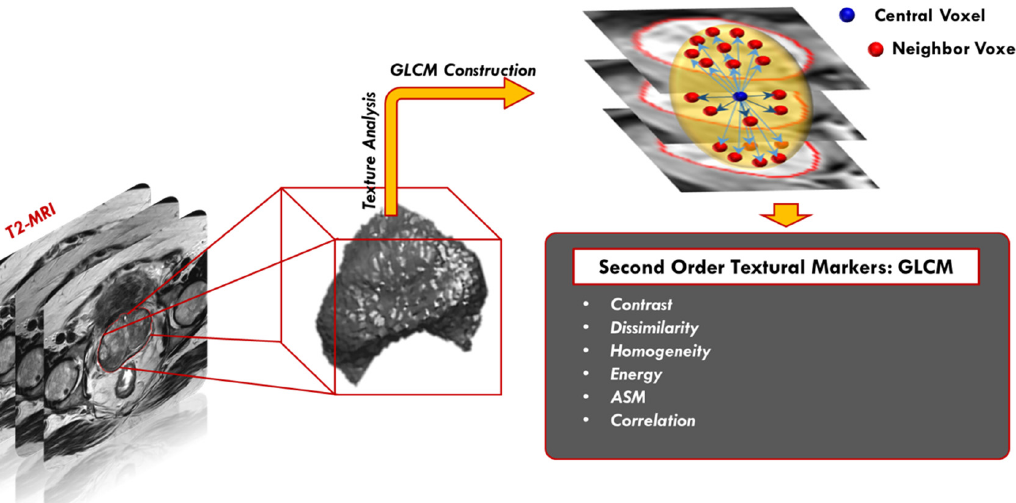
Figure 6. Second-order GLCM textural features extraction, where the central voxel of interest is shown in blue and the 26-neighbors are shown in red. The spatial relationship in the neighborhood block is obtained at different angles of zero, π